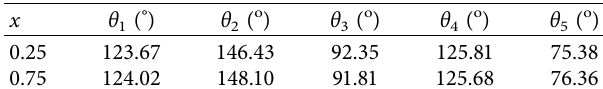
Table 5: Calculated values of bond angles of Ni